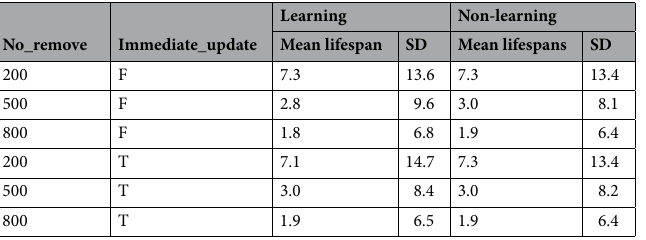
Table 1. Learning scenario does not increase the mean lifespan. Mean lifespans and SD are calculated from 10 replicates by pooling them together.